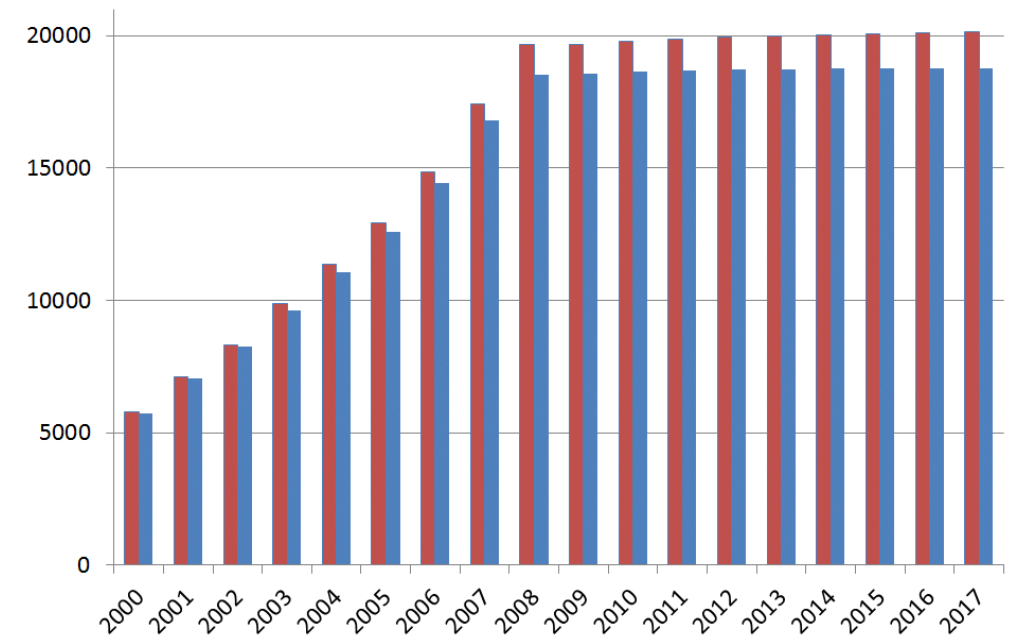
Figure 2. Protein counts from human UniProtKB/Swiss-Prot by create date (red). The blue columns include the additional selection for existence evidence at the protein or transcript levels (note the date is just for the entry into Swiss-Prot, not the first appearance of the sequence in TrEMBL that can be many years